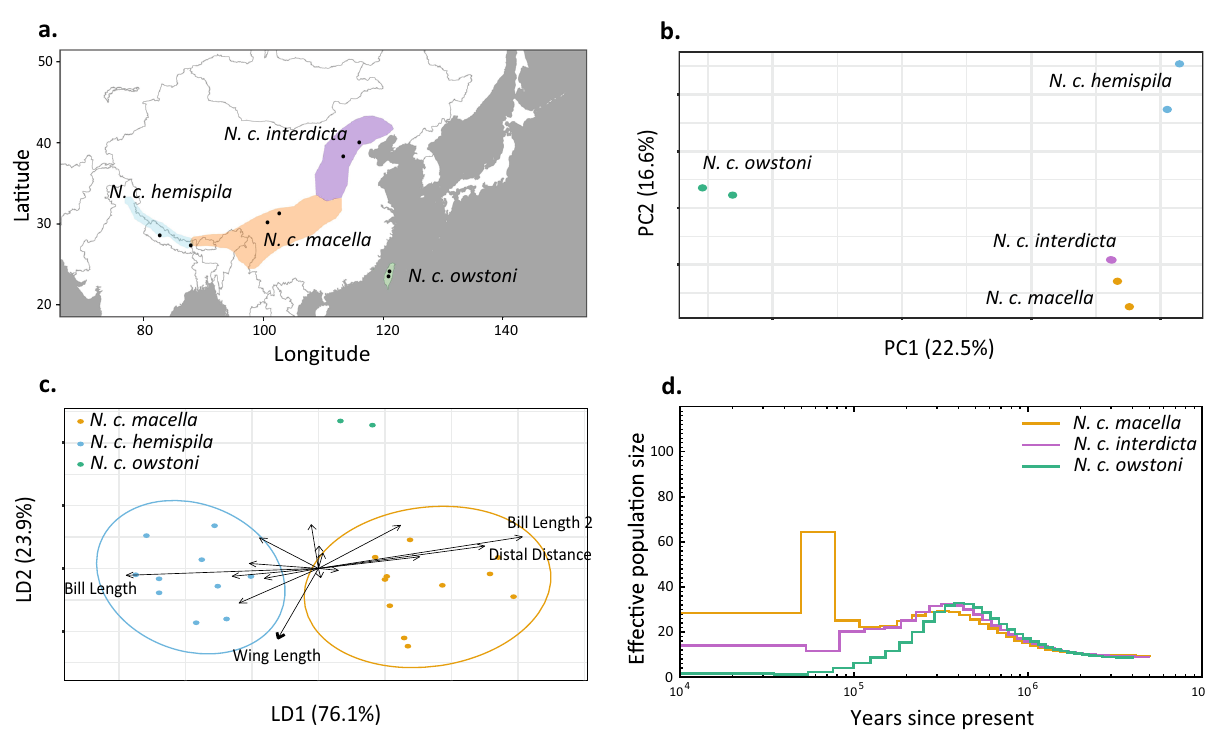
Fig. 4 Genetic and morphometric differentiation within the southern N. caryocatactes group. a Distribution of the four subspecies within the southern N. caryocatactes group. b Within-species genetic variation based on a PCA of 101,611 SNPs. c Linear discriminant analyses based on morphometric measurements of 23 southern N. caryocatactes museum specimens. N. c. interdicta had to be excluded due to lack of trait data. d Reconstruction of historical effective population size through time based on PSMC. N. c. hemispila was excluded from the analyses due to insuf fi cient genome